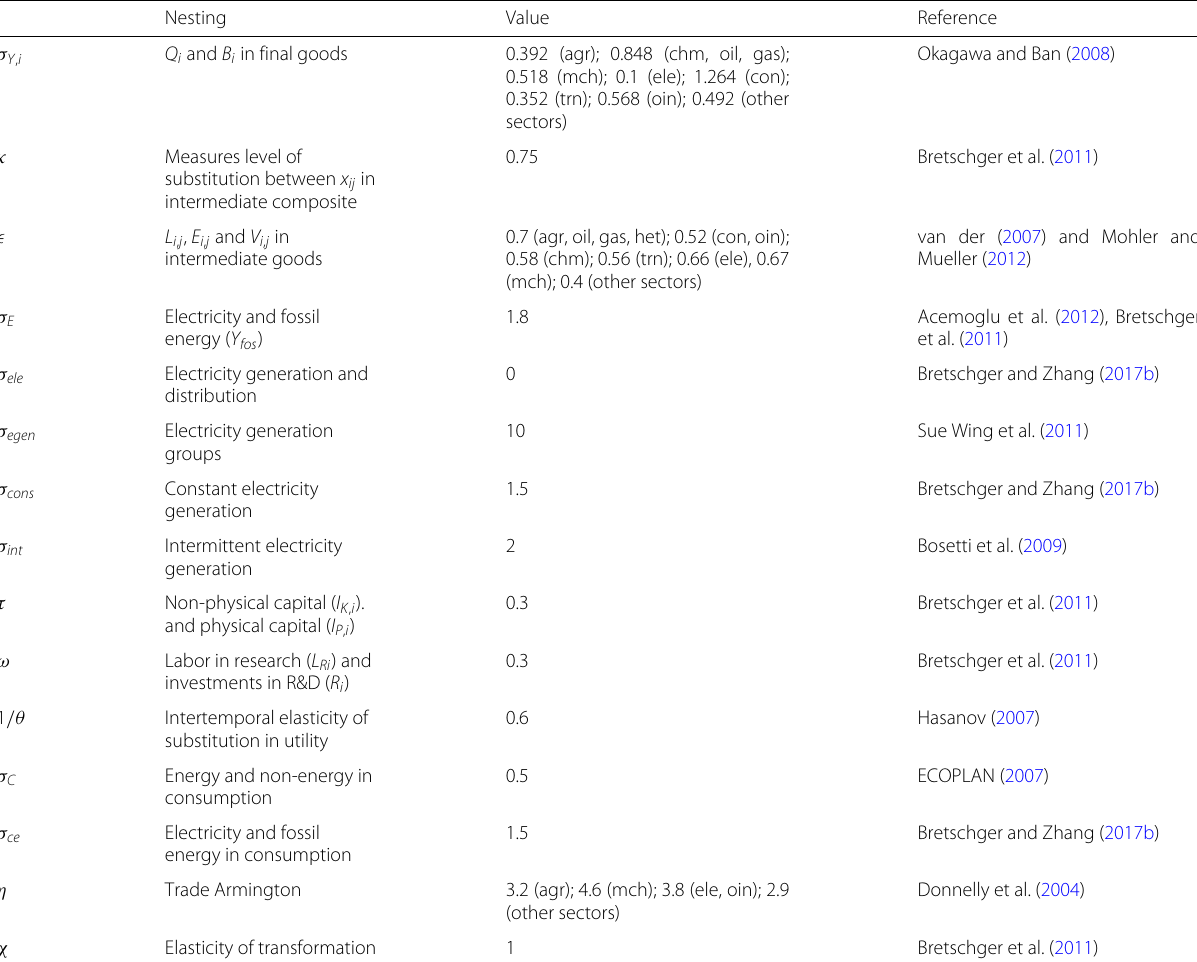
Table 1 Elasticities of substitution used in the model